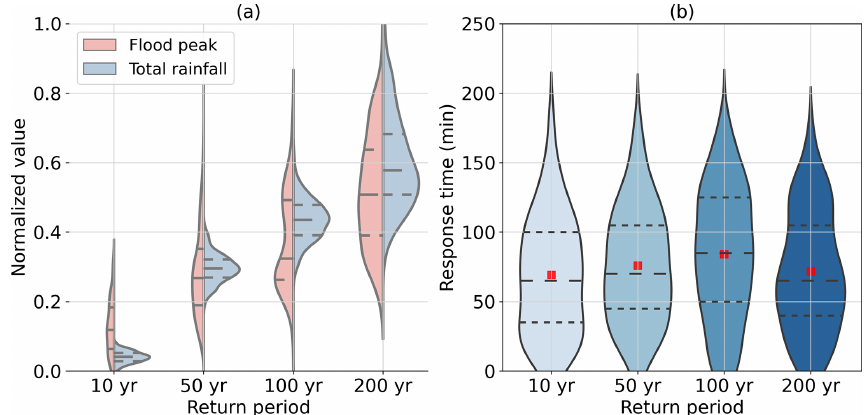
Figure 4. Violin plots of (a) normalized flood peak and normalized total rainfall and (b) response time from 10- to 200-year rainfall return periods. (The red dot indicates the mean value. The dashed line in the middle indicates the median value. Upper and lower dashed lines indicate the 75th and 25th quantiles, respectively.) The rainfall return periods are calculated with respect to the average rainfall rate over the entire DR watershed.